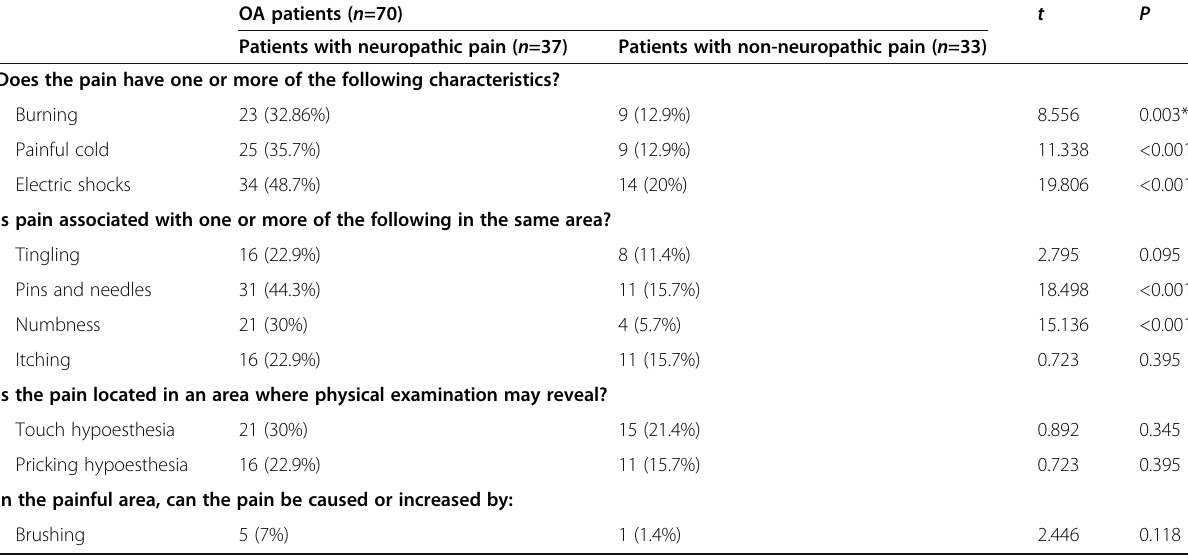
Table 2 Frequency of responses for individual items of DN4 questionnaire among OA patients OA patients ( n =70) Patients with neuropathic pain ( n